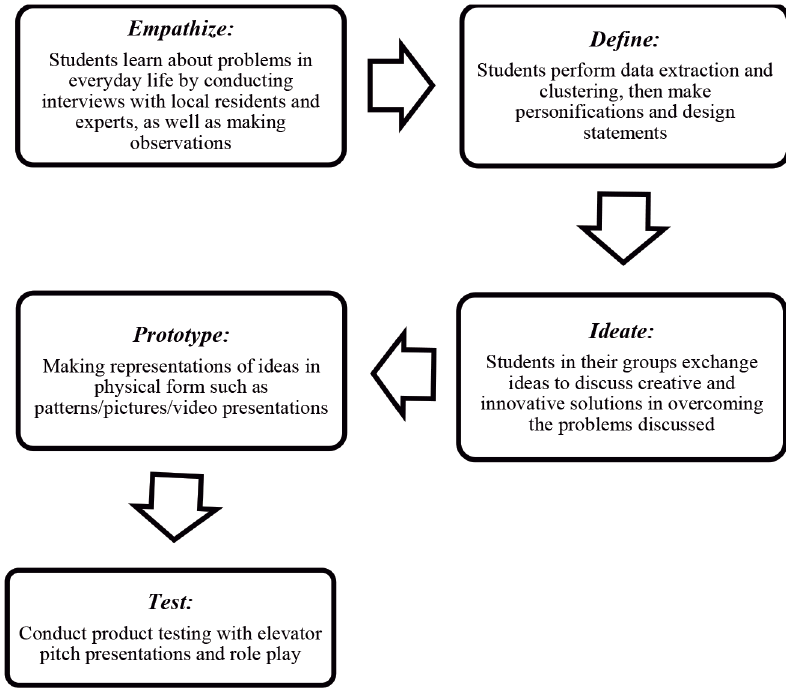
Figure 3. Five stages of Design Thinking integrated into